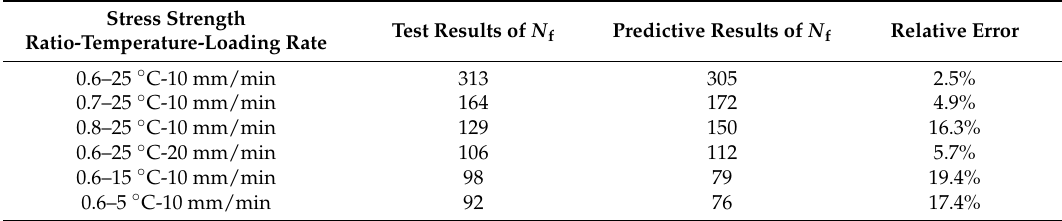
Table 7. Contrast results of fatigue